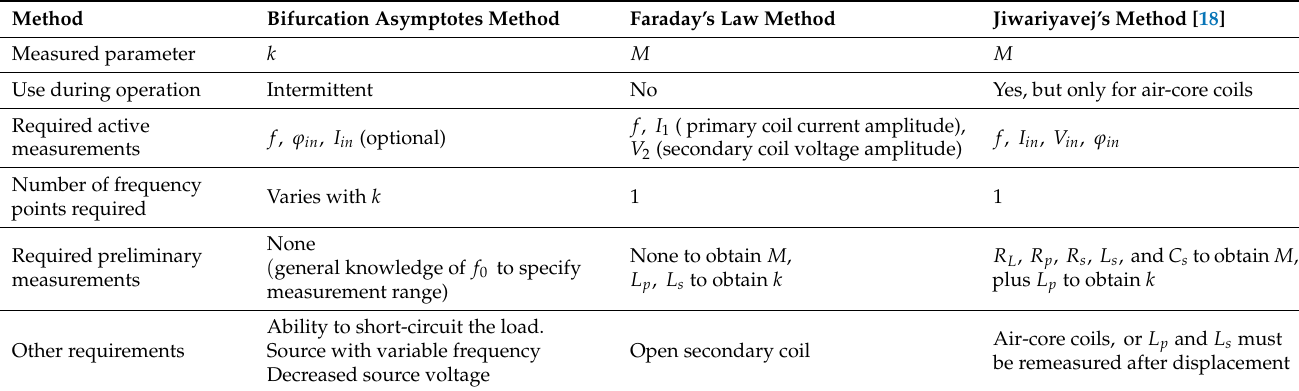
Table 4. Comparison of the practical aspects of the bifurcation asymptotes method with the selected estimation